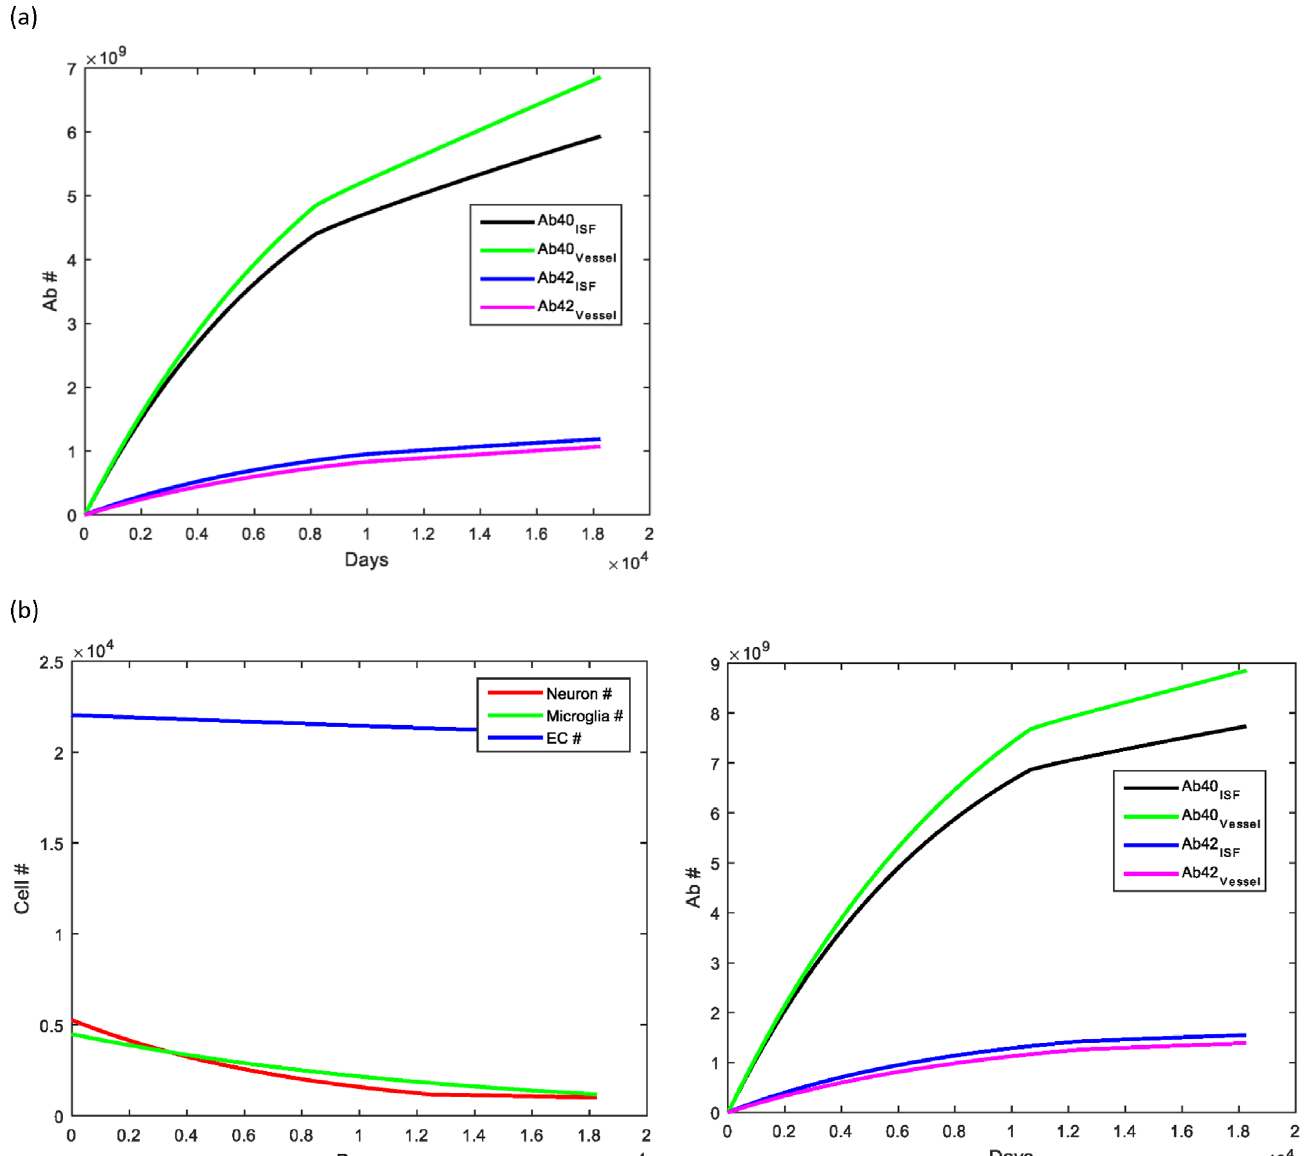
Fig 8. Sensitivity analysis of the model. (A)The sensitivity of the model to values that were estimated was studied to determine the range over which the model produced stable simulation results. Changing the initial concentration of A β from ½ x to 2x led to no changes in simulation result and demonstrating stability of this rate constant. (B) Changing the amount that A β generation would increase in response to a stimulus (k 4 ) showed that this parameter had a relatively narrow range of